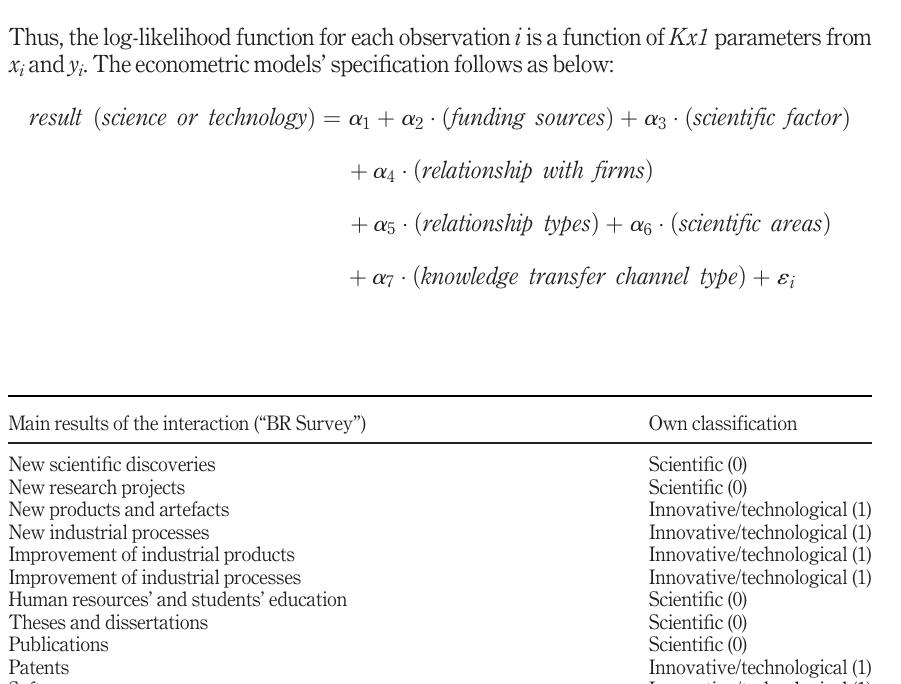
Table III. Main results of